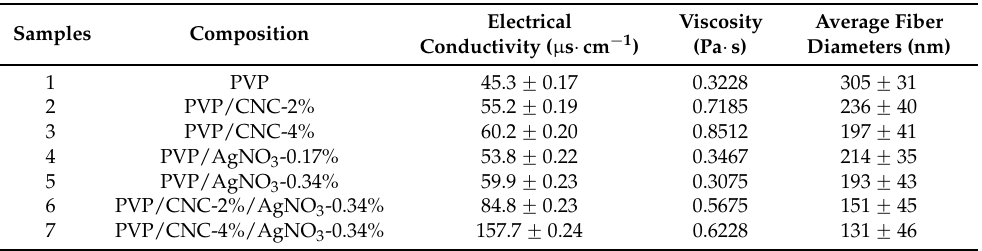
Table 1. Electrical conductivity of electrospinning pure PVP, PVP/AgNO 3 , PVP/CNC, and PVP/CNC/AgNO 3